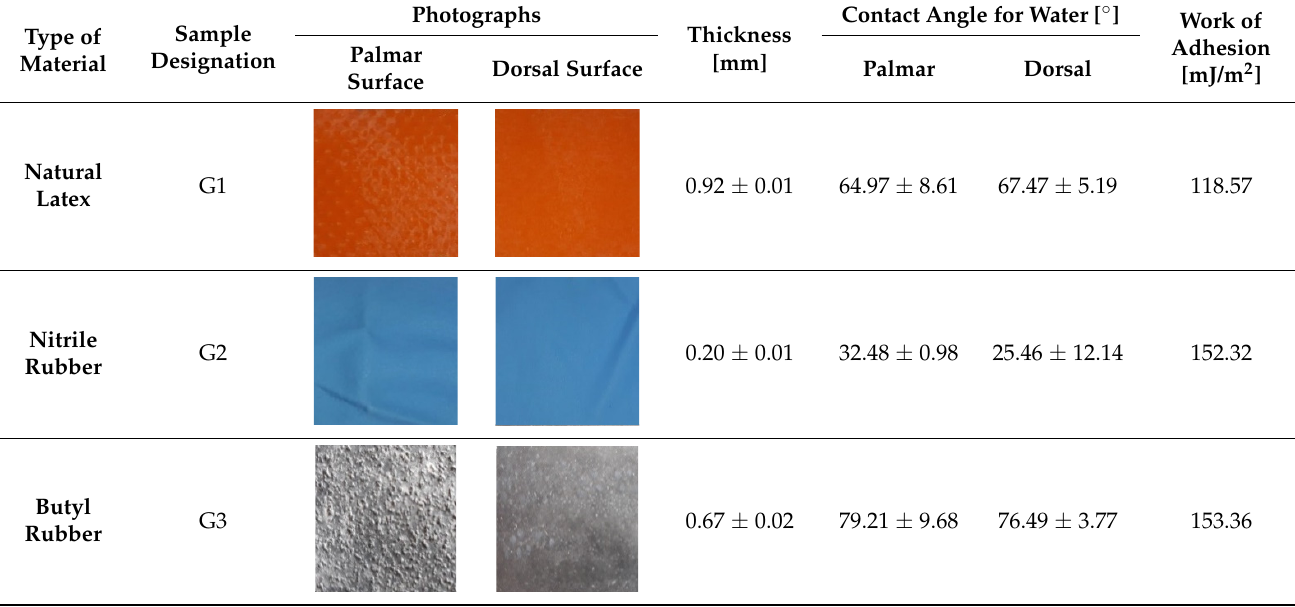
Table 1. Gloves used in the